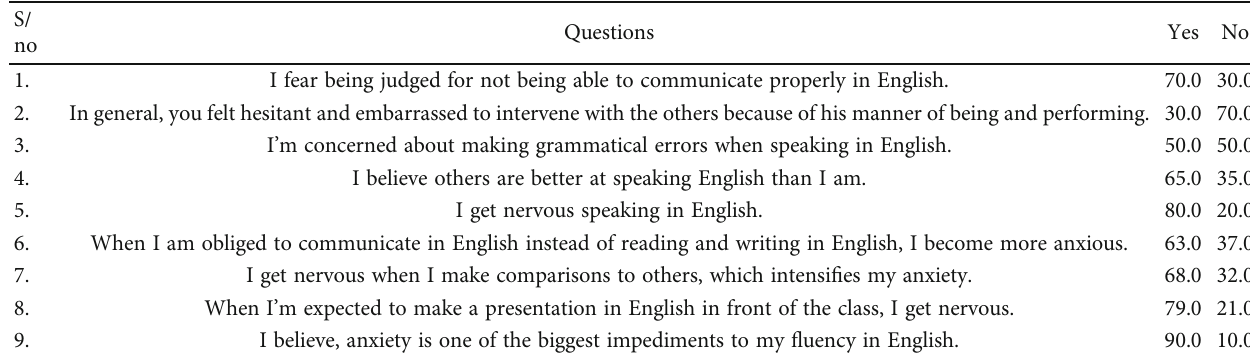
Table 1: Summarise the fi ndings from Section